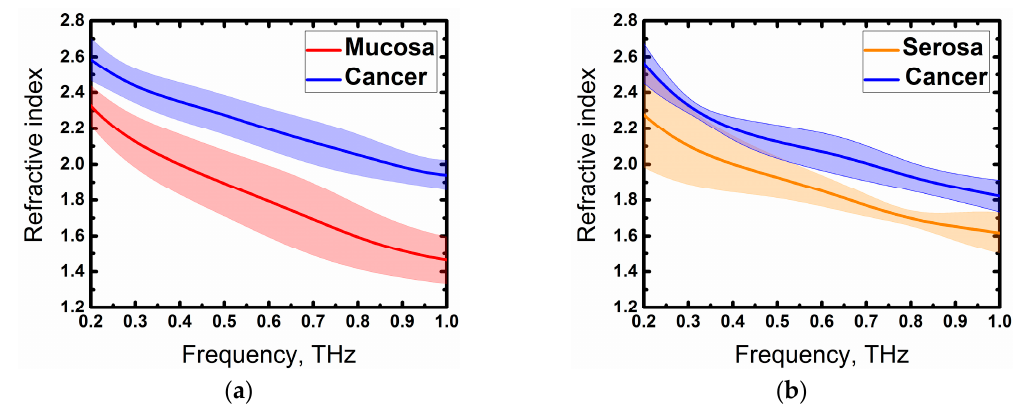
Figure 6. Refractive index of the investigated tissues from ( a ) mucous membrane and ( b ) serous membrane averaged of all